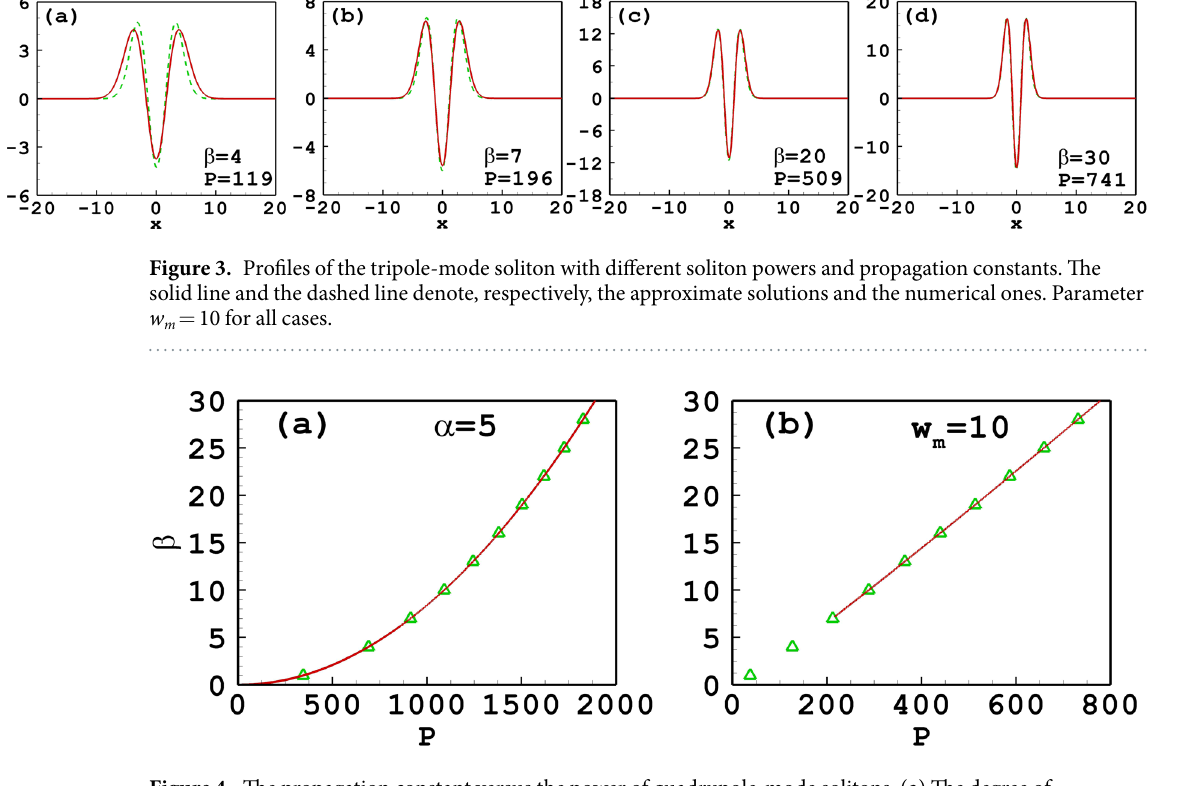
Figure 4. The propagation constant versus the power of quadrupole-mode solitons. ( a ) The degree of nonlocality is fixed at α = 5; ( b ) the width of the response function is fixed at w m = 10. The solid line and the triangles denote, respectively, the approximate solutions and the numerical